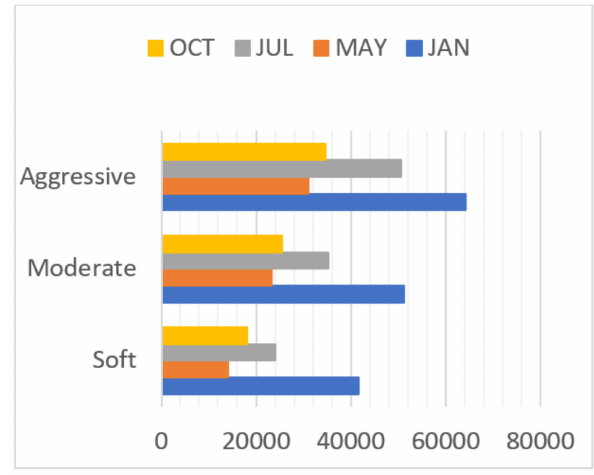
Figure 8. Total traded monthly Energy Credits in kWh.